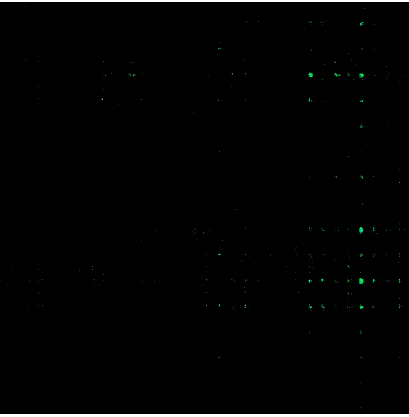
Figure 6. Examples of image features for mobile normal